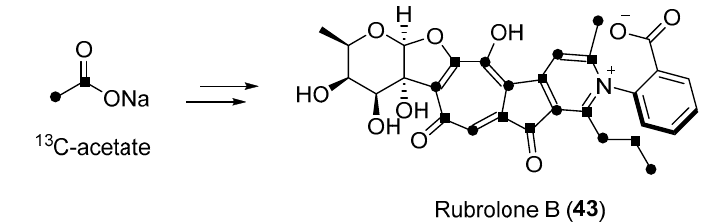
Figure 7. Structures of compounds 38 – 43 .